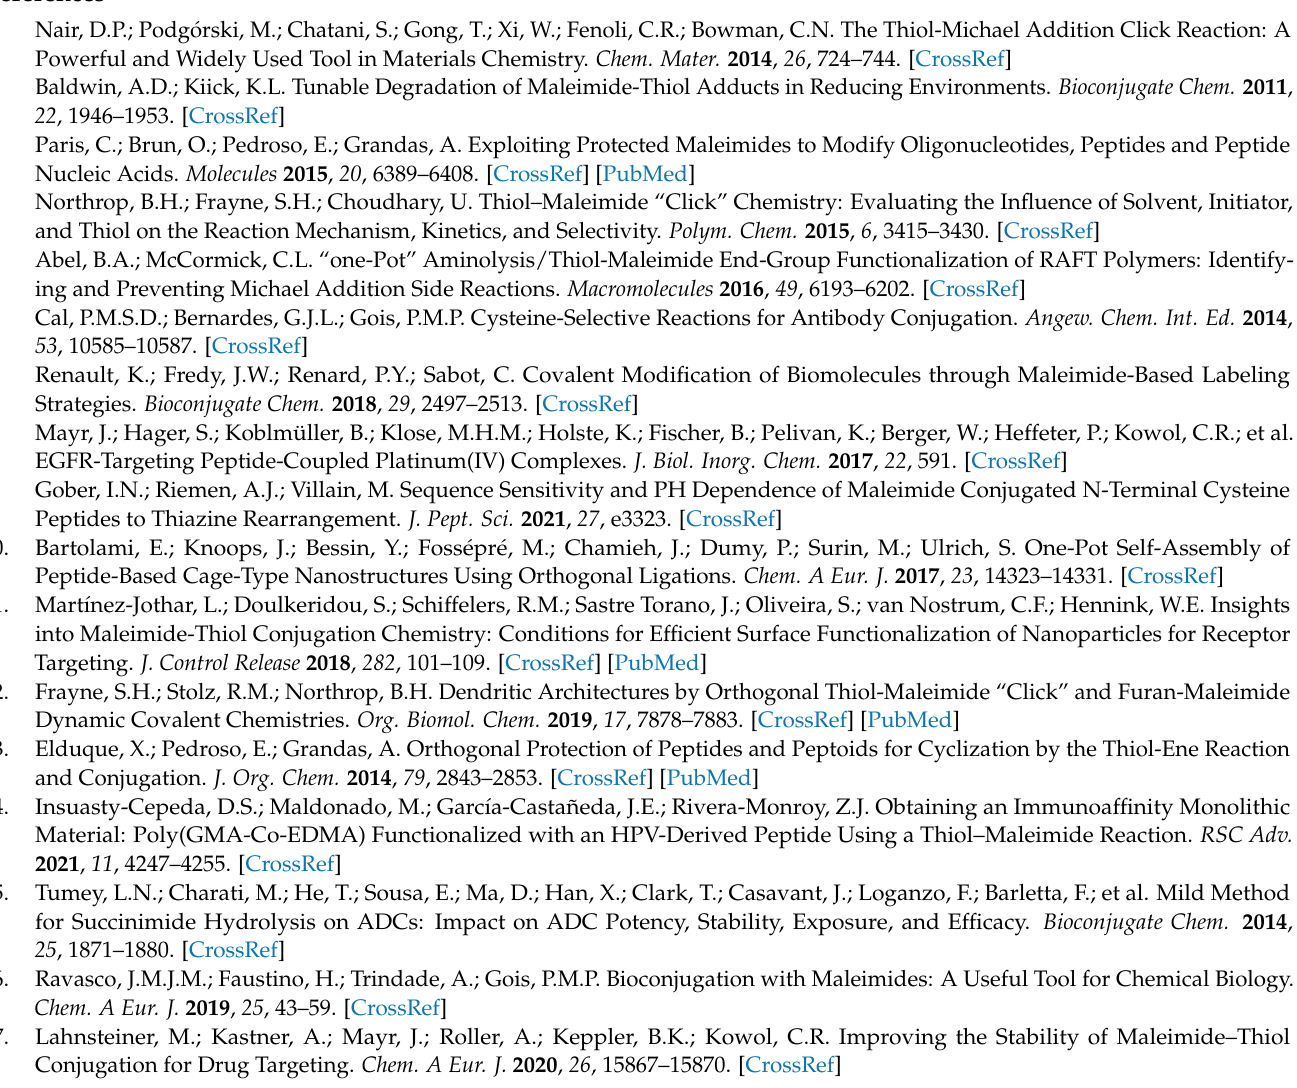
Figure S10. 1 H-NMR spectrum (400 MHz, MeOD, 303 K) of mix